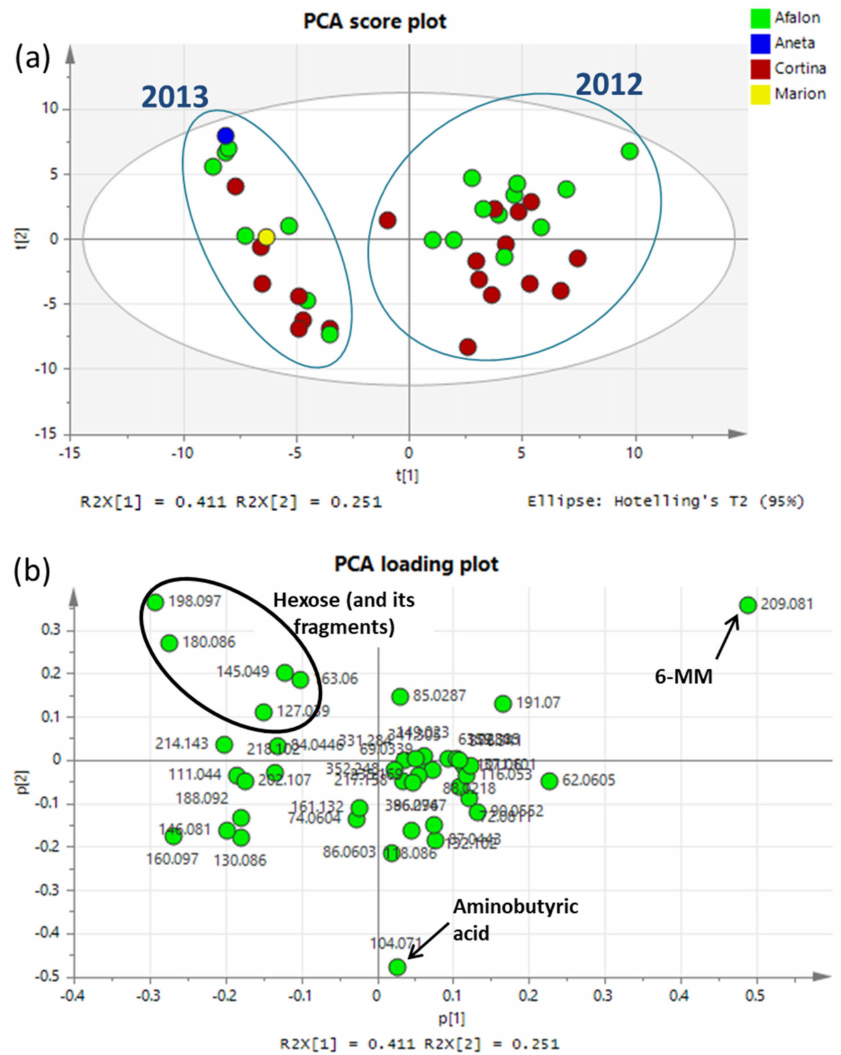
Figure 4. ( a ) The first two principal components analysis (PCA) score scatter plots of the whole set of samples (colored according to the varieties), t[1] is the first principal component (PC), representing 41.1% of the total variance, t[2] is the second PC, representing 25.1% of the total variance; ( b ) PCA loading plot, where positions of features (represented by measured exact mass and respective intensity) explain positions of samples in PCA score plot direct analysis in real time ion source coupled with a high-resolution mass spectrometer (DART(+)-MS) data).